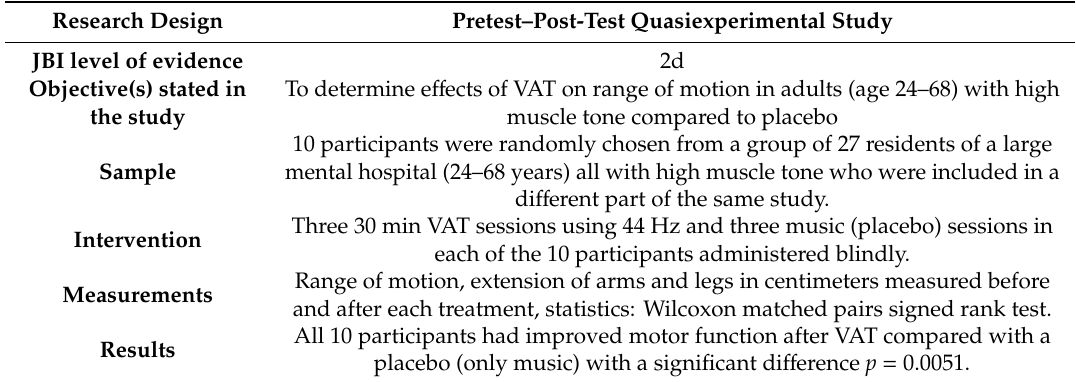
Table 9. Studies on adults with CP—Wigram, chapter 5